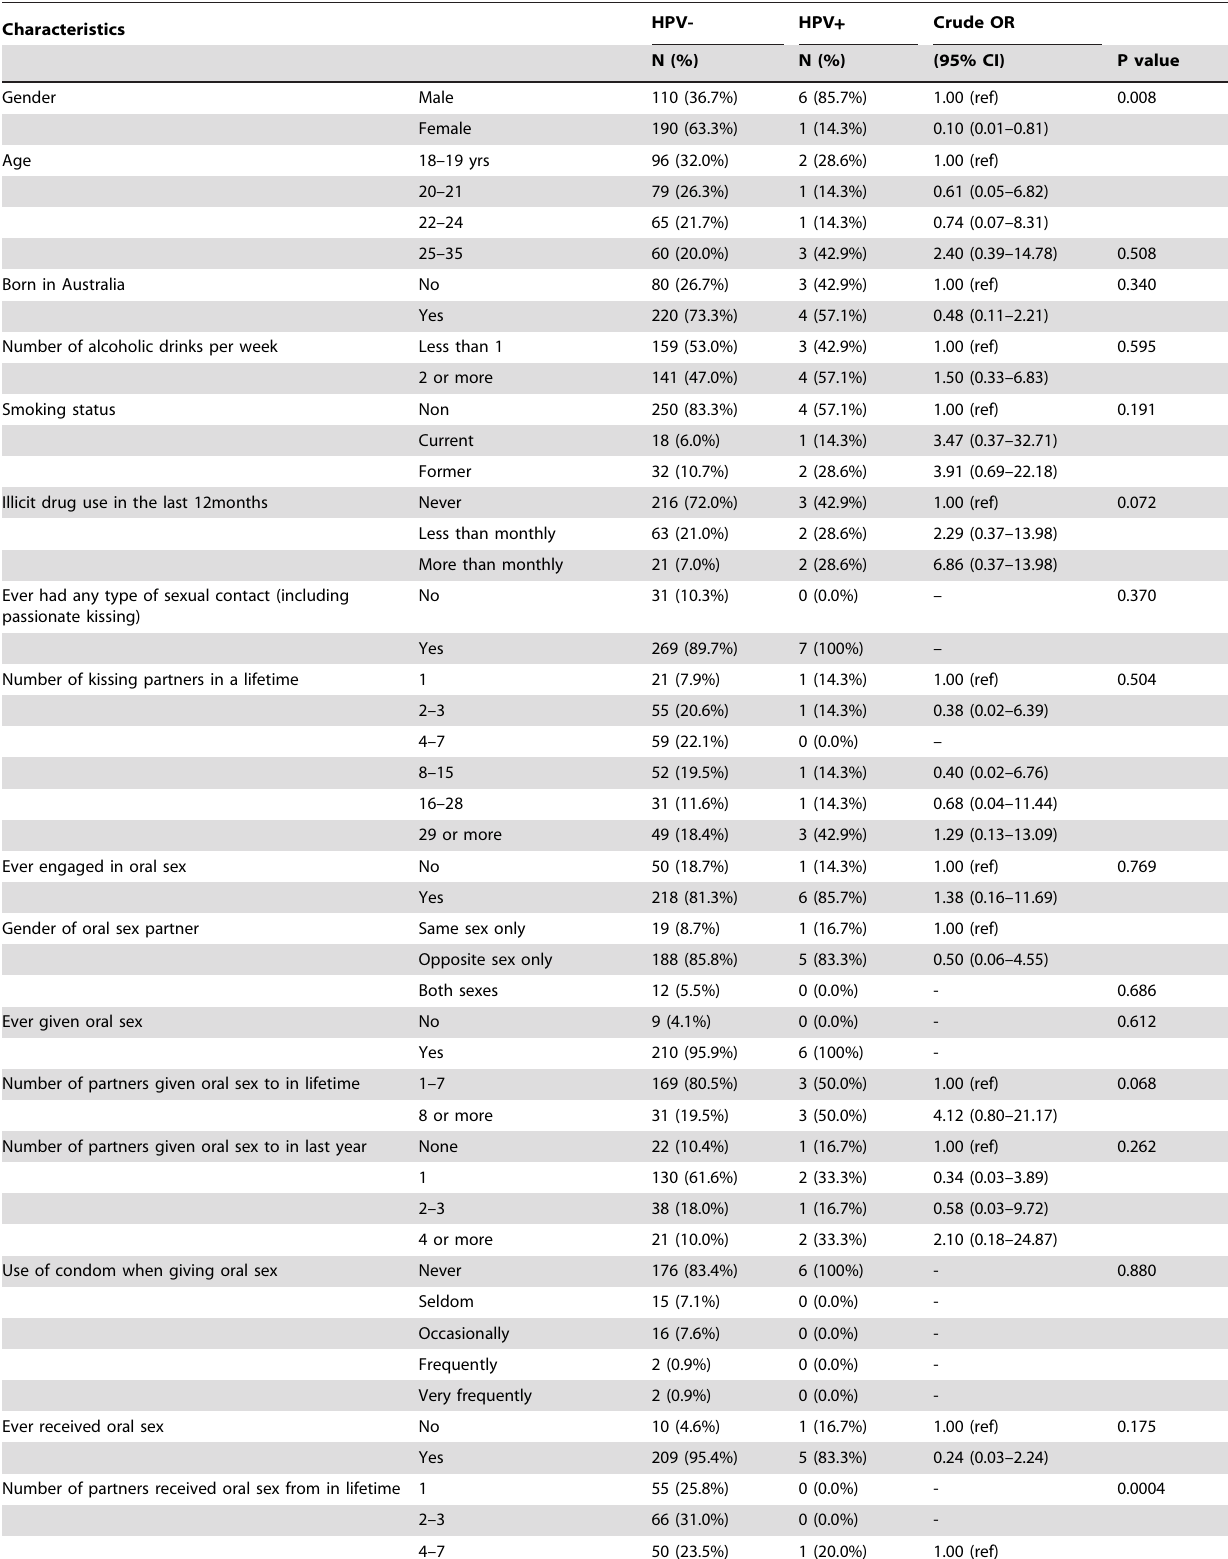
Table 2. Characteristics of HPV negative and HPV positive